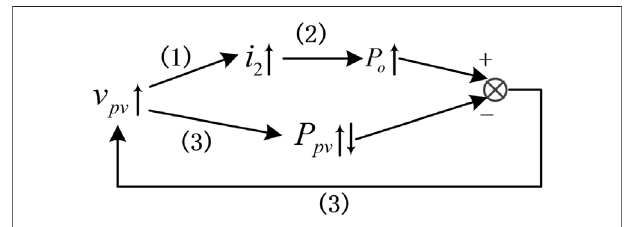
FIGURE 5 | Logical relation diagram of changes about P o , P pv , and v pv .